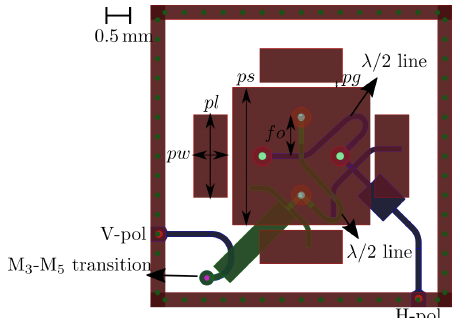
Figure 11. Final layout with feeding and matching networks, inter layer and PCB to package transitions (ground planes and grounding vias omitted).